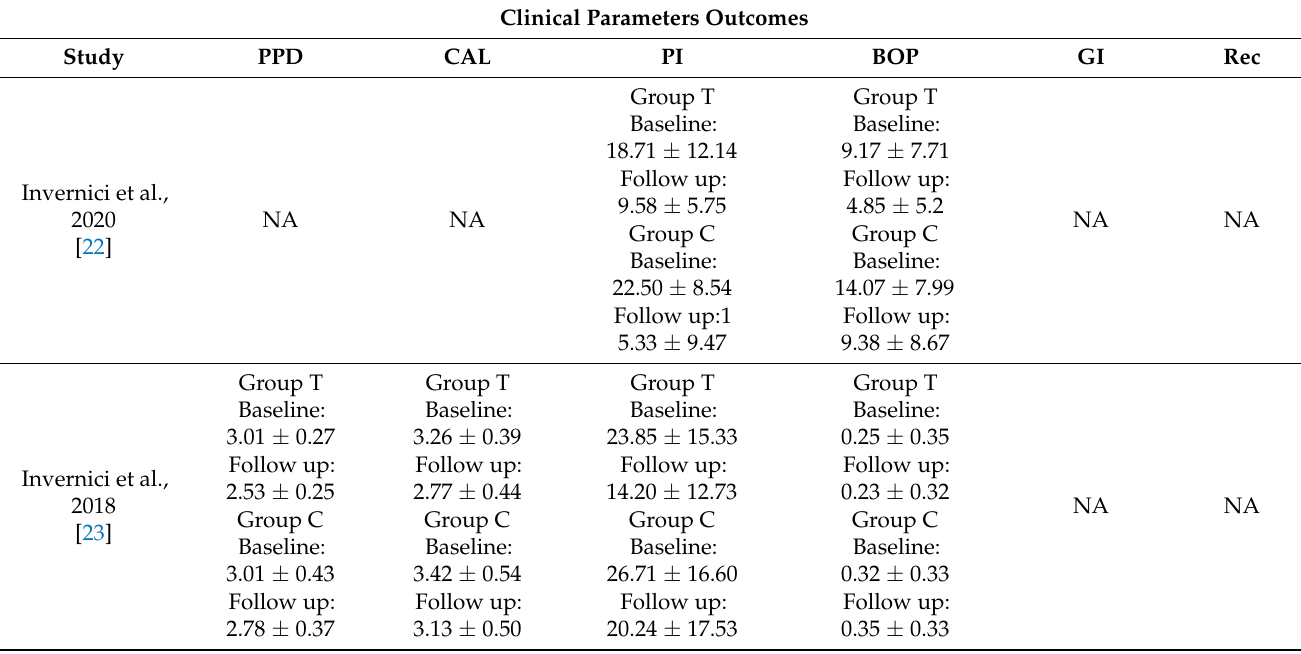
Table 3. Outcomes of the included studies.